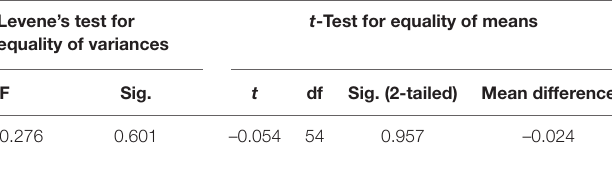
TABLE 6 | Independent t -test of pre-test results.